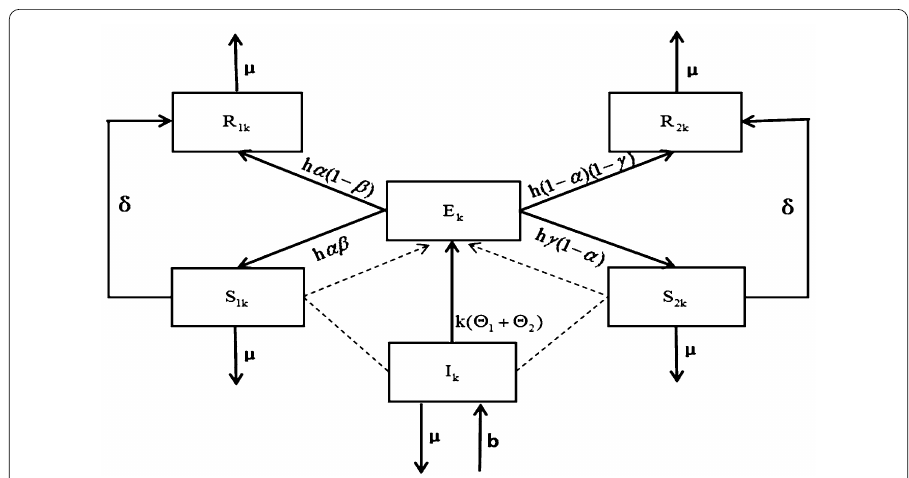
Figure 1 Structure of the rumor-spreading